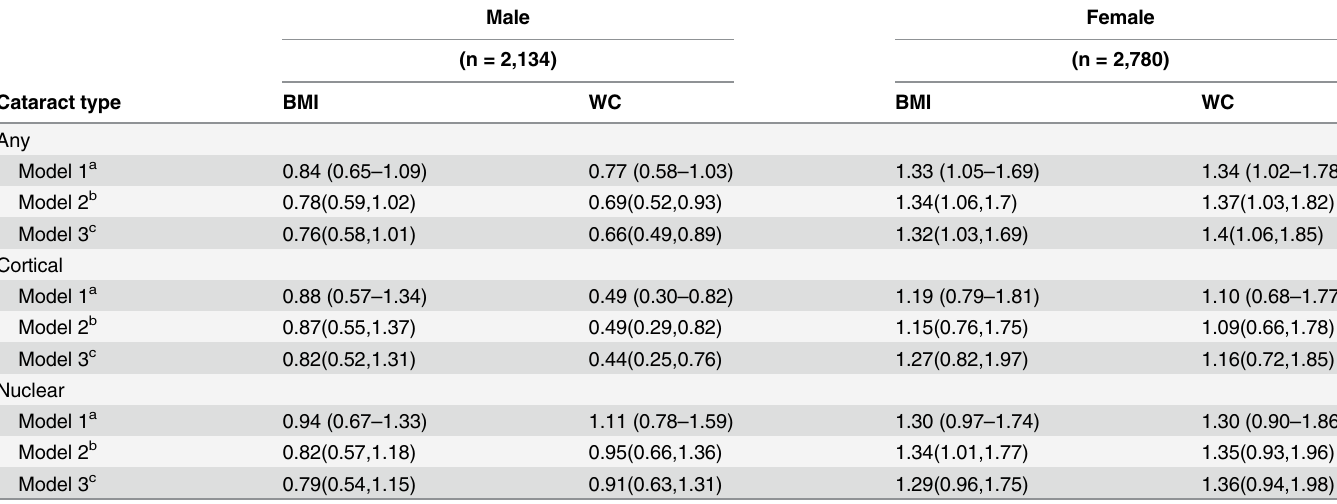
Table 3. The association between obesity and cataract types according to